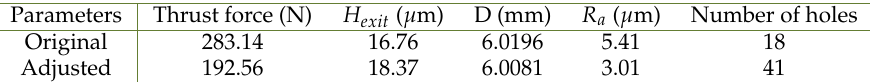
Table 5. Comparison results of the adjusted parameters and the original